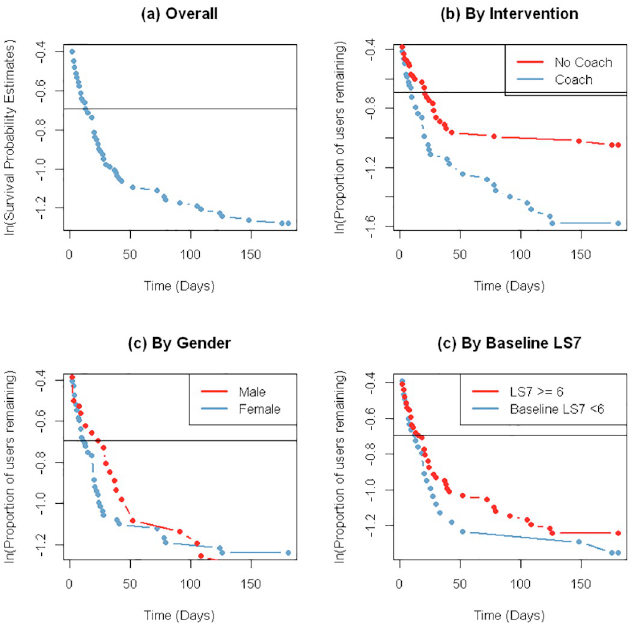
Fig 3. Logarithmic nonusage attrition curves in the MECA clinical